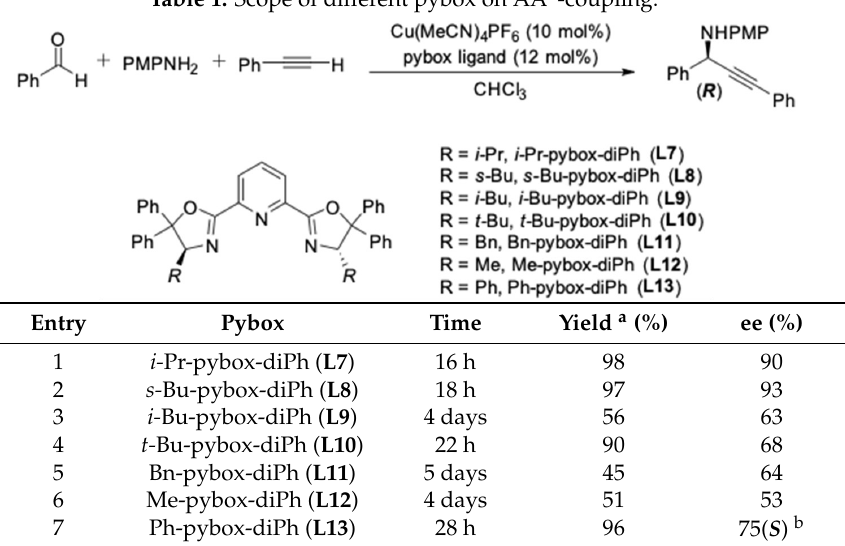
Table 1. Scope of different pybox on AA 3 -coupling.